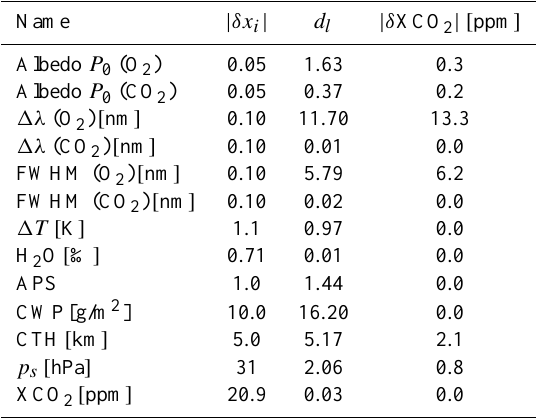
Table 4. Degree of non-linearity of selected state vector elements calculated for the “dry run” reference scenario. Given are the name of the state vector element, the absolute deviation from the reference state vector, the degree of non-linearity, and the absolute XCO 2 er- ror when using a linear instead of the iterative